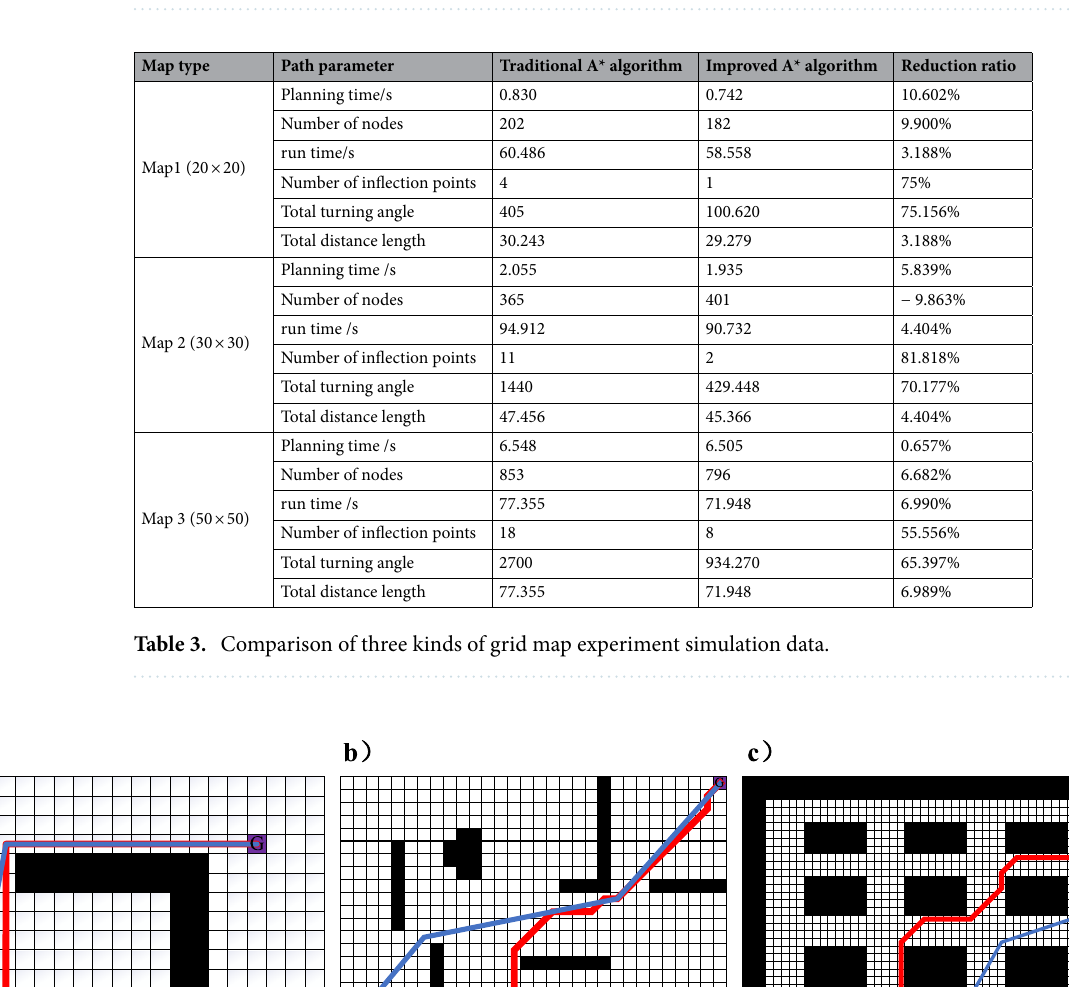
Figure 3. Three different grid maps. ( a ) Map 1 ( b ) Map 2 ( c ) Map 3.